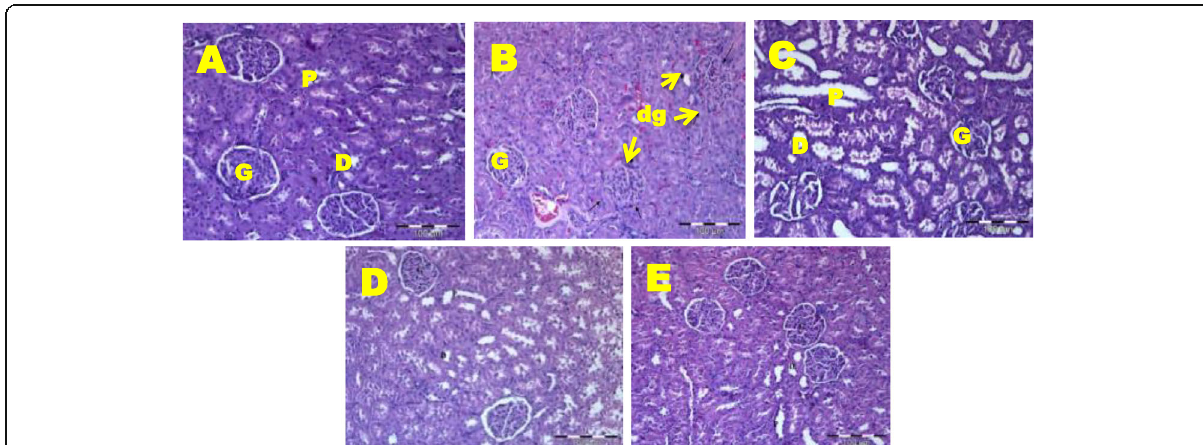
Fig. 2 Histopathology of kidney in NC, OC and GMF supplemented rats. Haematoxylin and eosin staining of renal tissues showing dilated glomerulus (marked as “ dg ” ) (× 20). G, Glomeruli with Bowman ’ s capsule; D, Distal tubule; P, Proximal tubule; A, normal control (NC); B, obese control (OC); C, 200 mg G. mangostana flesh / kg body weight (GMF 200); D, 400 G. mangostana flesh / kg body weight (GMF 400); E, 600 G. mangostana flesh / kg body weight (GMF